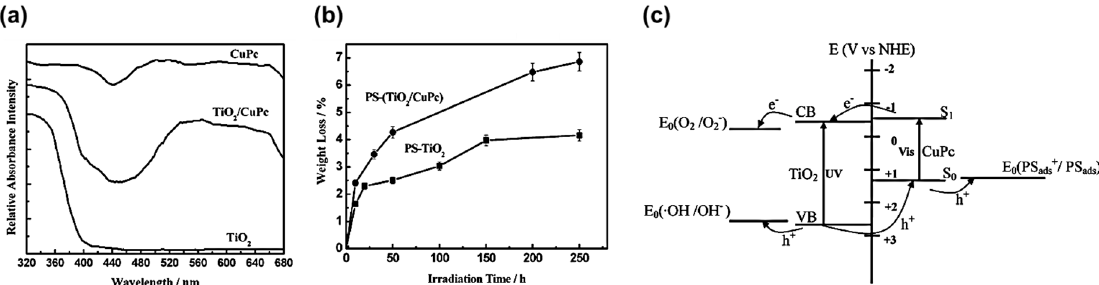
Figure 9. Photodegradation of PS-(TiO 2 /CuPc) film. ( a ) The UV-VIS absorption spectra of TiO 2 , TiO 2 /CuPc, and CuPc samples. ( b ) Weight loss curve of PS-TiO 2 and PS-(TiO 2 /CuPc) samples. ( c ) The schematic charge separation mechanism of TiO 2 /CuPc sample under visible and UV light radiation [55]; reprinted (adapted) from [55] with permission from the American Chemical